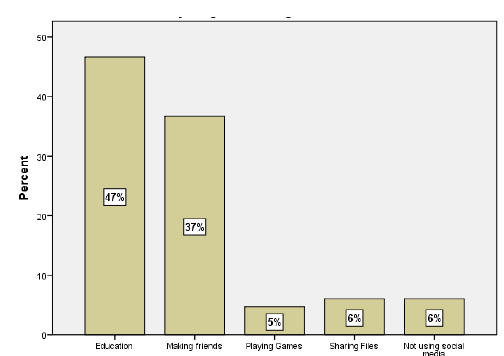
Figure 5: Bar chart showing percentage of respondents’ goal for using social media